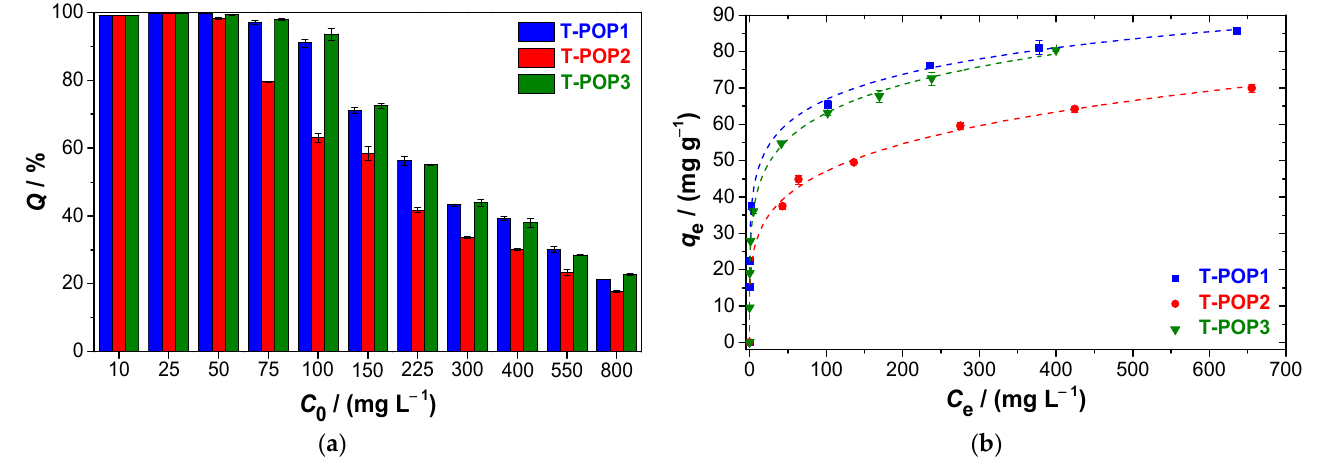
Figure 7. Removal of MO from water: ( a ) effect of initial concentration on adsorption efficiencies and ( b ) adsorption isotherms by different polymers (25 °C). The dashed curves represent the fitting of different models to the experimental data: Hill equation (T-POP1 and T-POP3) and Freundlich equation (T-POP2). Table 2. Fitting parameters of different models of isotherms for MO